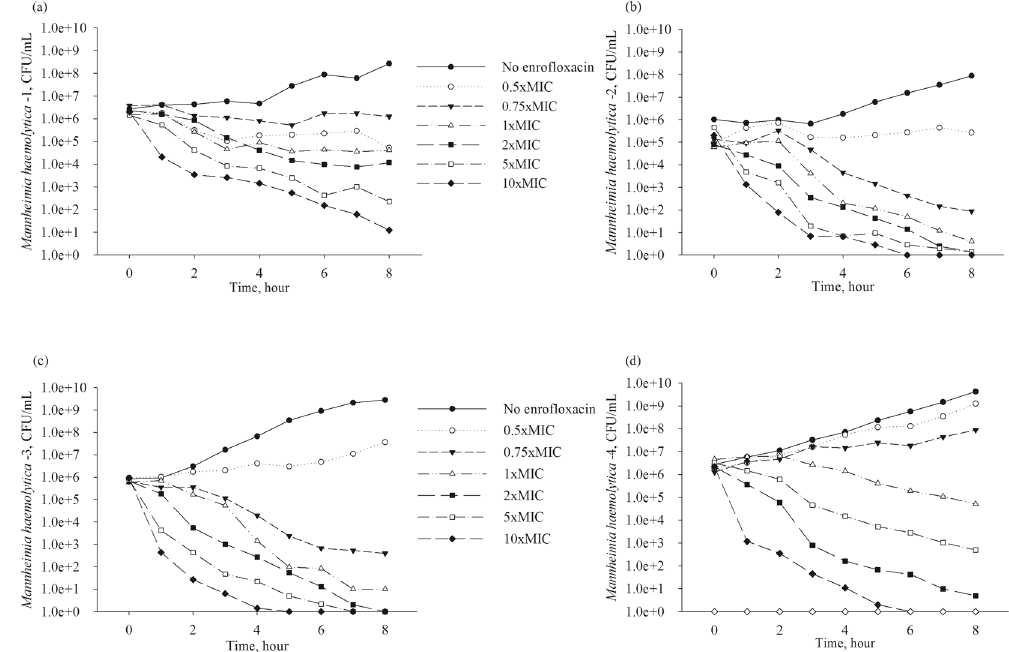
Figure 1. Data from time-kill experiments with the fluoroquinolone enrofloxacin for four isolates of Mannheimia haemolytica from bovine respiratory disease cases. For each isolate and enrofloxacin concentration combination, the average result of at least two replicates of the experiment is plotted. (The isolate number corresponds to that in Table